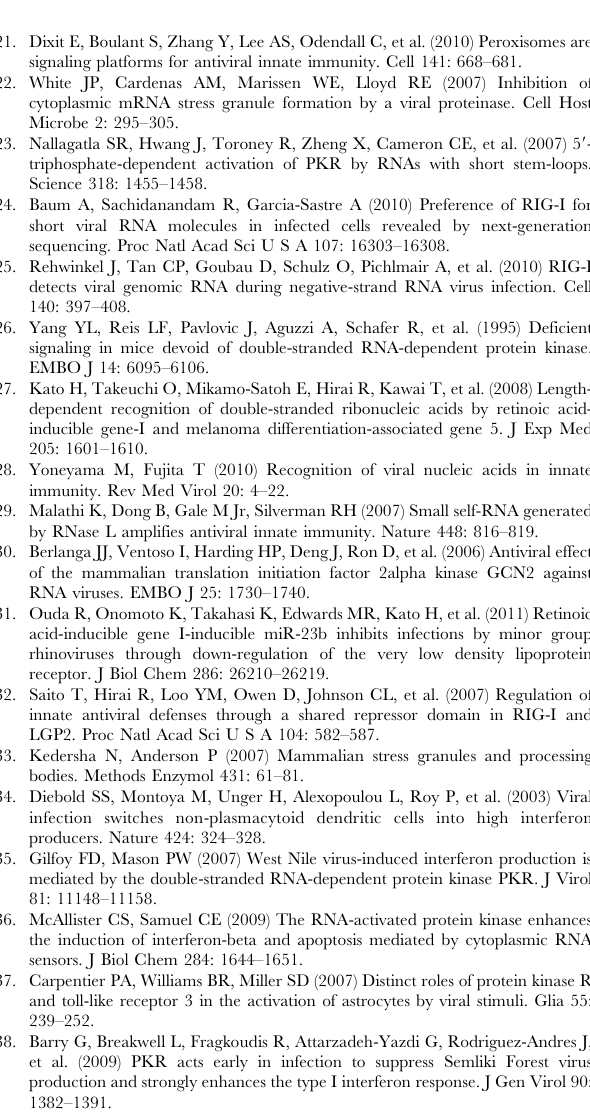
Figure S6 IAV-induced formation of avSGs was inhibit- ed in PKR knockdown cells. (A–E) HeLa cells were transfected with control siRNA (N.C) or siRNA targeting three independent parts of human PKR mRNA ( # 1 3). (A) At 48 h after transfection, cells were harvested and PKR and actin were detected by Western blotting. (B–E) At 48 h after transfection, cells were mock-treated (open bar) or infected with IAVA¨ NS1 qPCR (B) . Immunostaining of HeLa cells transfected with control infection with IAVA¨ NS1 (C) . Cells were also examined by staining for foci of RIG-I (D) , TIAR (E) after 12 h infection. Percentages of cells containing the respective foci are indicated. Data are presented as the mean standard 6 error of the mean (SEM). Figure S7 Total RNA from IAV-infected cells but not uninfected cells induces avSG formation and IFN-aˆ gene activation. (A and B) Wild-type MEF were mock-treated (no RNA) or transfected with total RNA extracted from